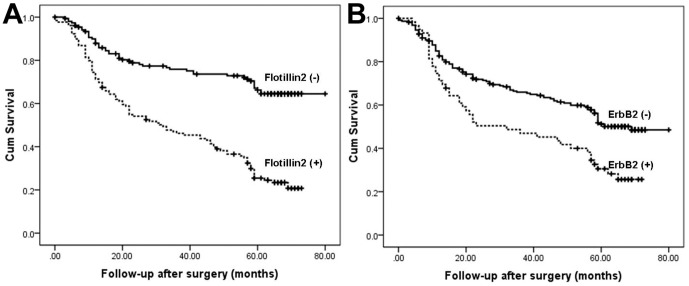
Kaplan-Meier curves for patient survival.(A) Patients with an erbB2-positive tumor showed a significantly shorter survival period after surgery than those with an erbB2-negative tumor (p  = 0.014). (B) Patients with a flotillin2-positive tumor showed the worst outcome. High flotillin-2 and erbB2 expression are significantly correlated with poor patient outcome (p<0.001).